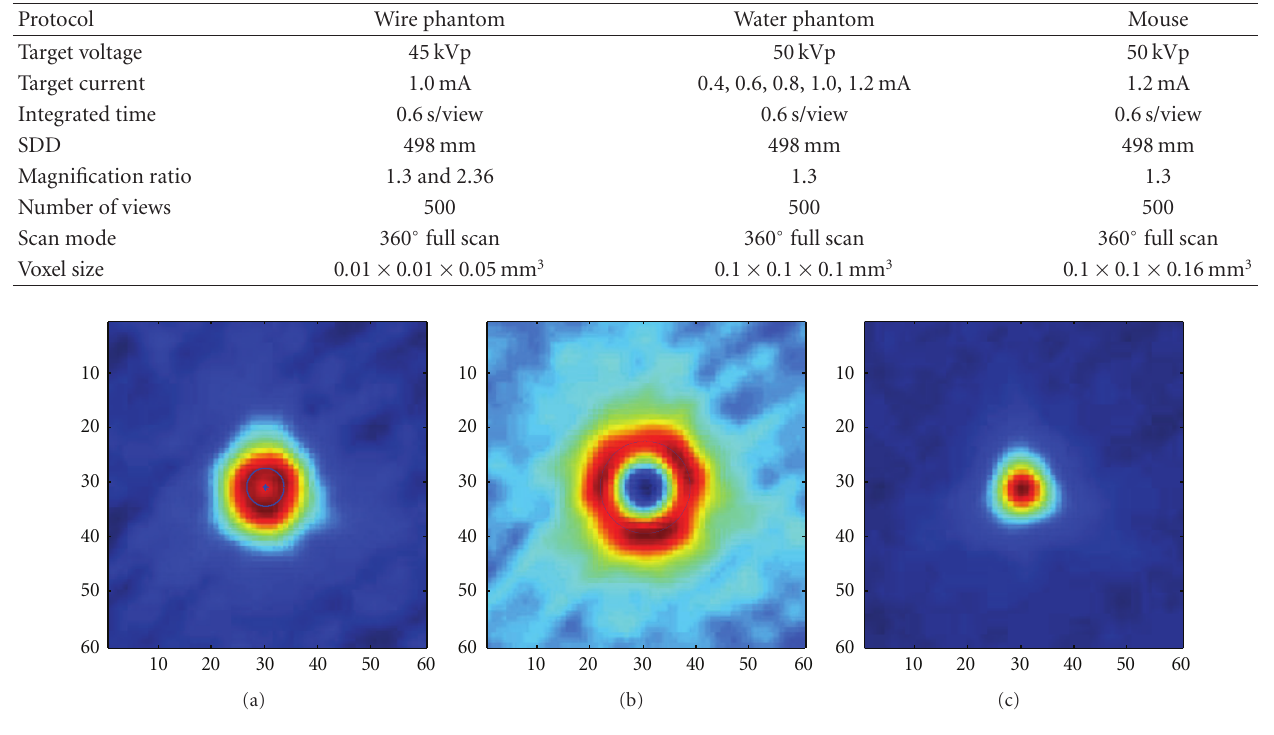
Figure 6: Wire reconstruction results with di ff erent horizontal o ff set calibration: (a) reconstruction image with a horizontal o ff set. (b) calibration implemented in incorrect direction, (c) excellent geometric calibration